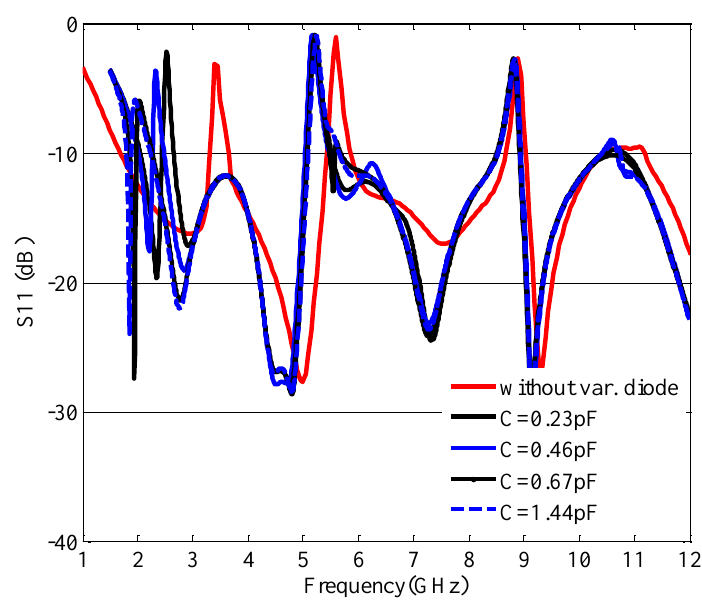
Figure 9. Simulated return loss with tunable notch frequency for case III in Figure 3.